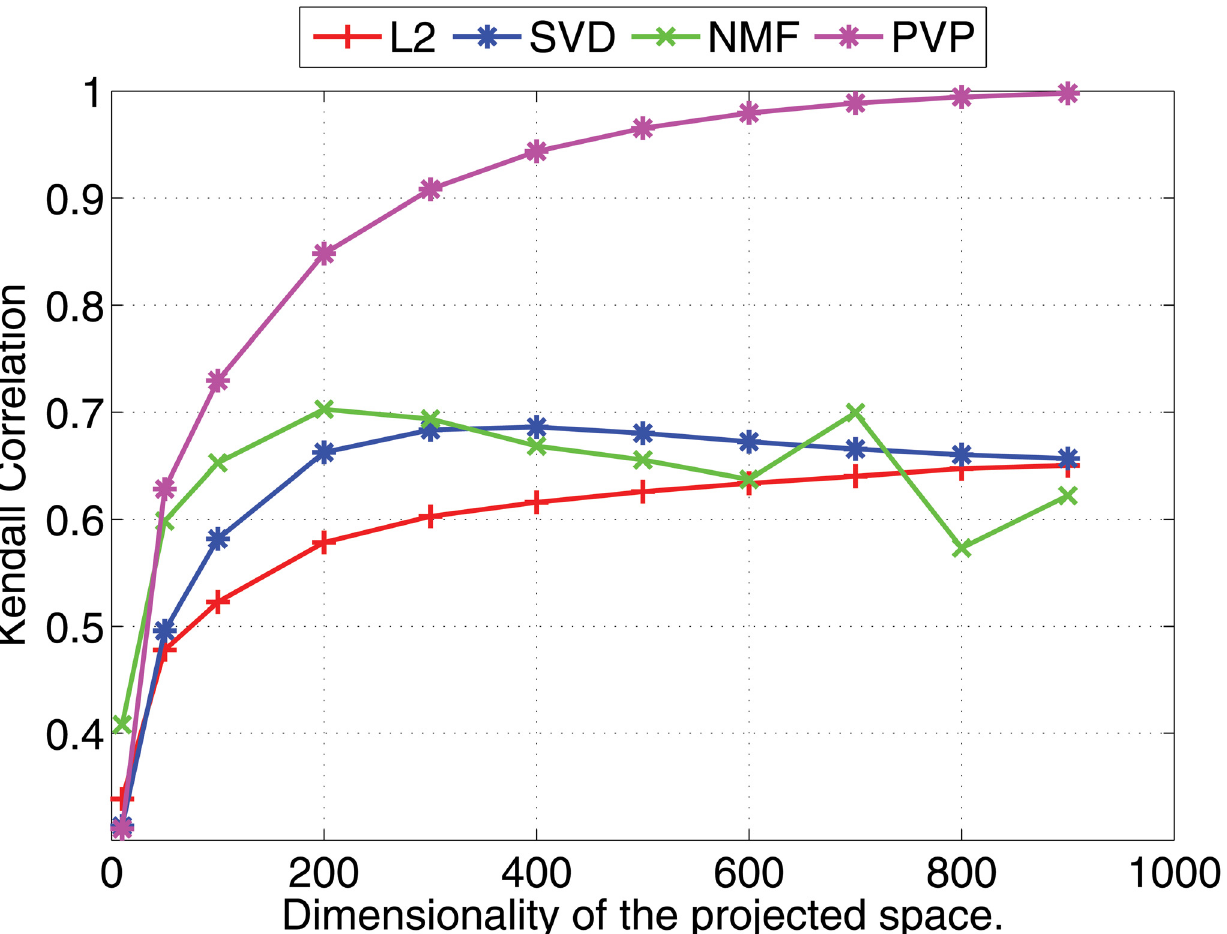
Fig 5. Nearest neighbor prediction with English feature vectors. Pearson ’ s r correlation coefficients for different dimensionality reduction methods are shown under varying dimensionalities (Feature vectors are 1000 dimensional).